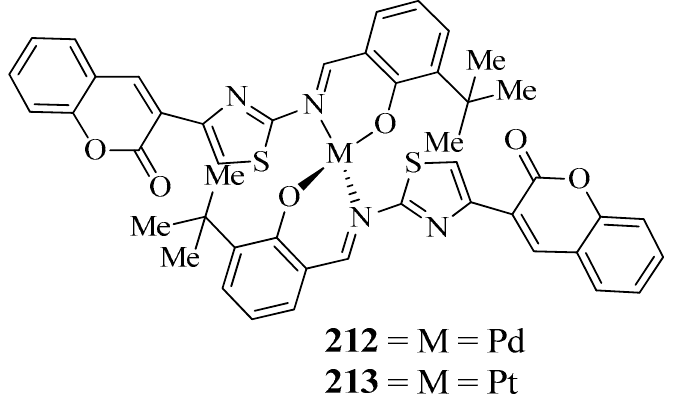
Figure 8. Structures of coumarin-derived imine–metal complexes ( 212 , 213 ).